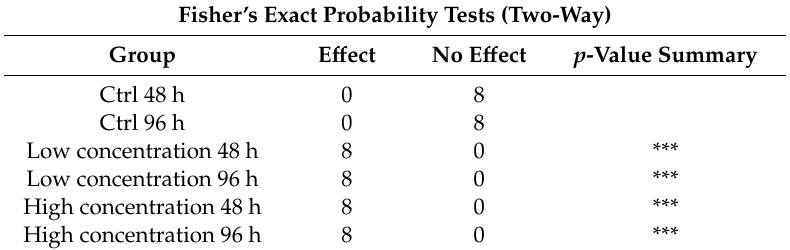
Table 1. Statistic comparison between the groups exposed to CPF and the control group with respect to the presence of morphological alterations in treatment groups ( n = 8).